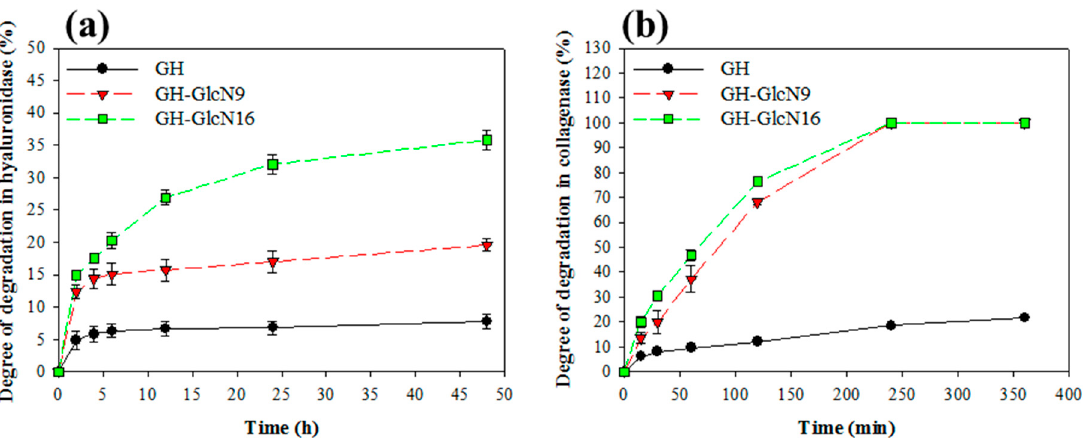
Figure 2. Degradation of GH, GH-GlcN9 and GH-GlcN16 cryogels in ( a ) hyaluronidase and ( b ) collagenase.